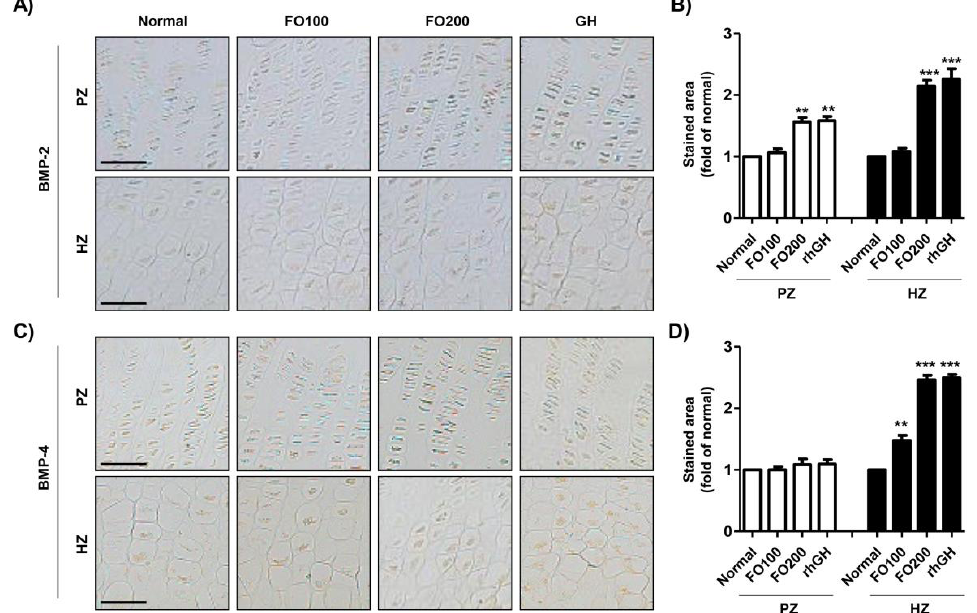
Figure 4. Immunohistochemical localization of bone morphogenic proteins in the proximal tibial growth plate. BMP-2 ( A ) and BMP-4 ( C ) were detected in the proliferating and hypertrophic zone of the proximal tibial growth plate. Scale bar; 50 µ m. ( B , D ) The stained area of BMP-2 and BMP-4 was analyzed using ImageJ ® and calculated in terms of the fold of the control. Data are expressed as means ± SD ( n = 6). ** p < 0.01 and *** p < 0.001 vs. normal. BMP-2, bone morphogenetic protein-2; BMP-4,